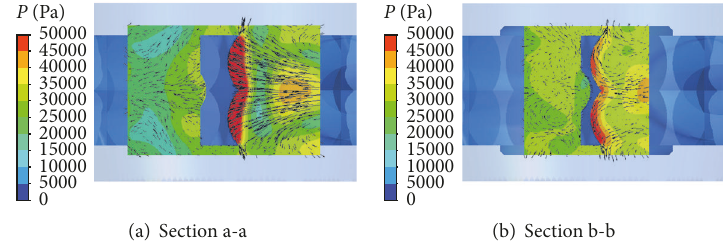
Figure 18: Static pressure distributions and absolute velocity vectors of Blade B ( 𝜃 ∗ = 36 ∘ , 𝑛 = 250 ,000 min −1 ).